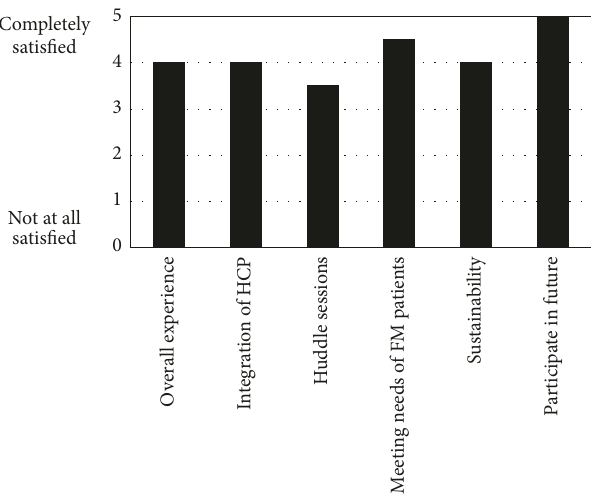
Figure 1: Survey conducted with HCPS on their views of the model of